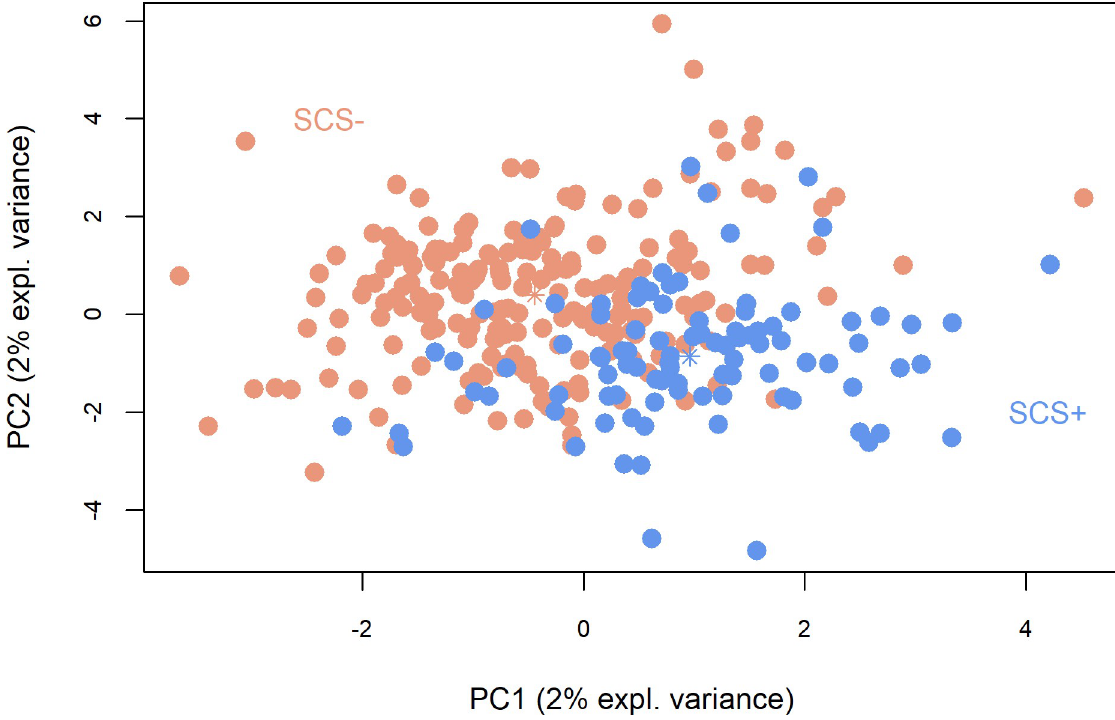
Fig 2. Sparse partial least squares discriminant analysis between divergent somatic cell score (SCS) lines. SCS+: ewes selected for high somatic cell score i.e. susceptible to mastitis; SCS-: ewes selected for low somatic cell score i.e. resistant to mastitis.